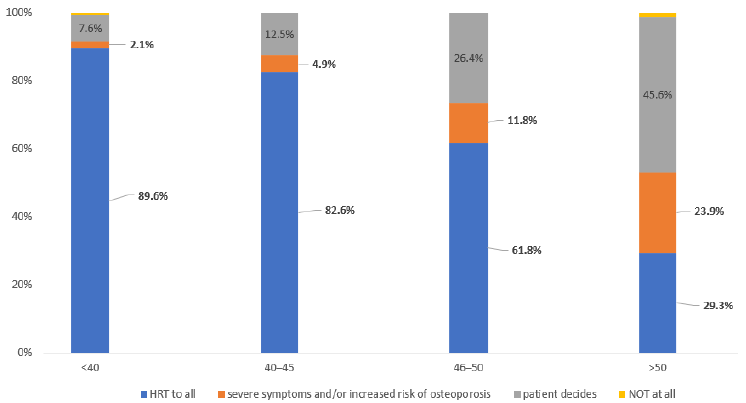
Figure 4. HRT and women’s age: the percentages of responders prescribing HRT to different age groups after surgical menopause in women with endometriosis.